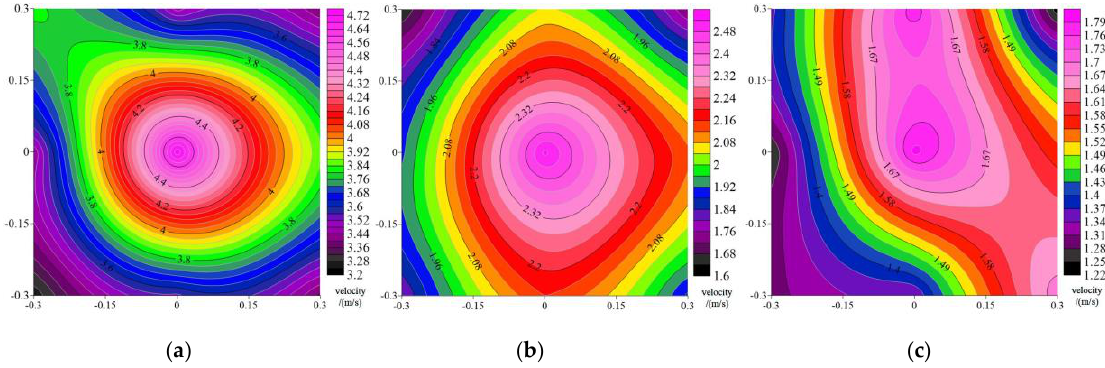
Figure 12. Wind farm data cloud map at heights of 0.4 m, 0.7 m, and 1.0 m in surfer13. ( a ) Speed cloud at 1.0 m altitude; ( b ) Speed cloud at 0.7 m altitude; ( c ) Speed cloud at 0.4 m altitude.